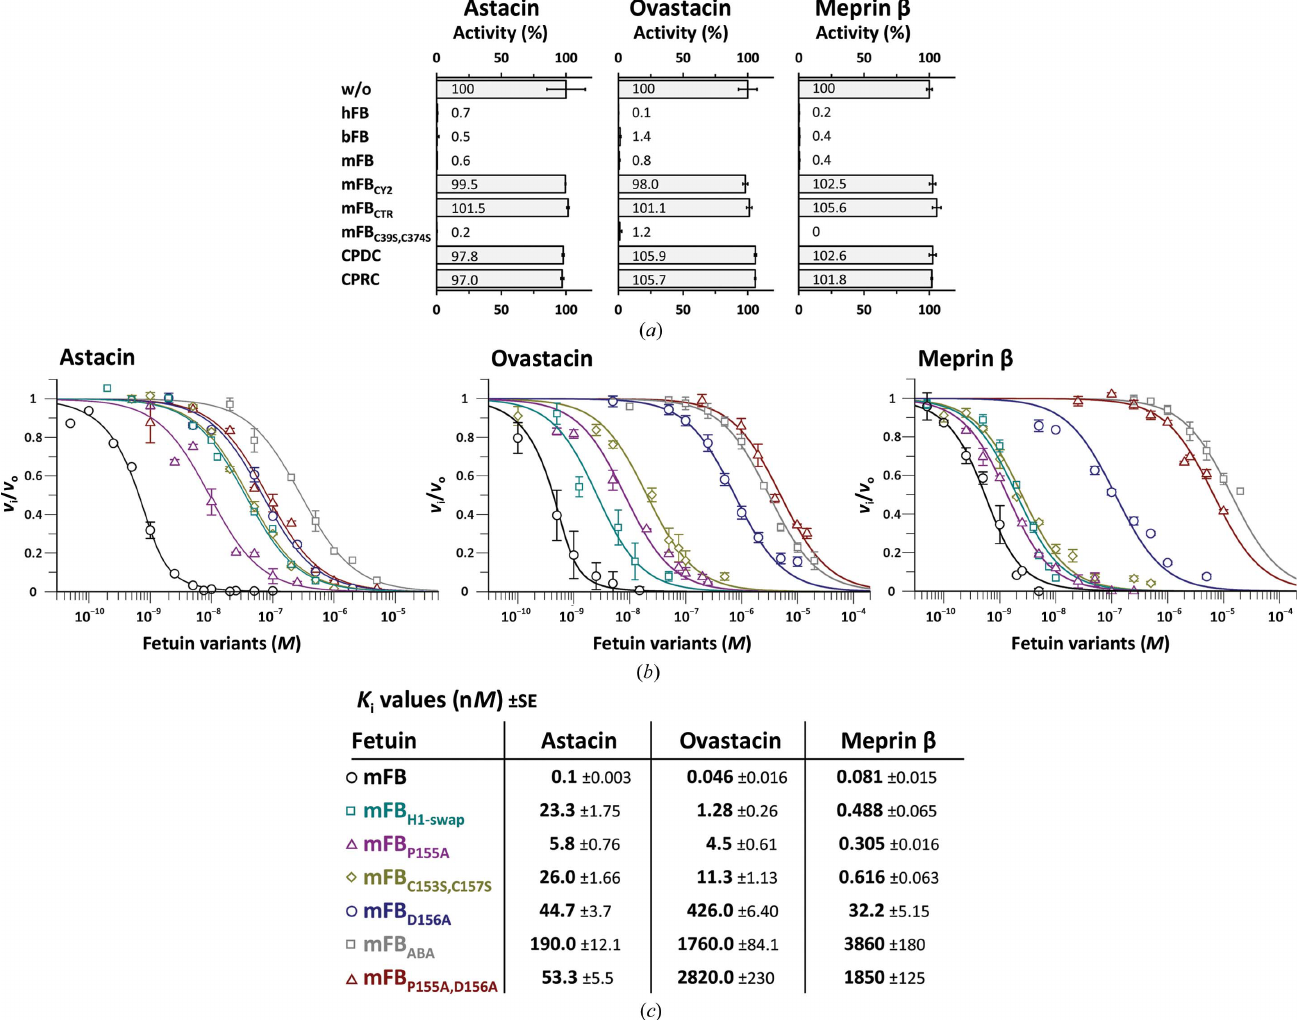
Figure 3 In vitro validation of the inhibitory mechanism. ( a ) Activity (%) of astacin (at 1 n M concentration), meprin (cid:3) (at 1 n M concentration) and ovastacin (at 5.6 n M ) in the presence of fetuin-B variants at 300 n M (CPDC and CPRC) or 12.5 n M (other variants). Full astacin, meprin (cid:3) and ovastacin activities (100%) correspond to substrate-turnover rates of 35.4 (cid:8) 5.7, 7.7 (cid:8) 0.2 and 10.7 (cid:8) 0.8 n M s (cid:4) 1 , respectively; w/o, without fetuin; hFB, human fetuin-B; bFB, bovine fetuin-B; mFB, murine fetuin-B; mFB CY2 , CY2 domain of mFB; mFB CTR , CTR domain of mFB; mFB C39S,C374S , double point mutant of murine fetuin-B; CPDC and CPRC, cyclic peptides comprising the respective sequences. Experiments were performed in triplicate; error bars indicate standard deviations. ( b ) Plot of fractional velocity (logarithmic scale) with different fetuin-B variants: mFB, murine fetuin-B; mFB ABA , variant with CY1 and CTR from mouse fetuin-A and CY2 from mFB; mFB H1-swap , mutant replacing CY2 hairpin I with CY1 hairpin I; mFB P155A , mFB D156A , mFB P155A,D156A and mFB C154S,C157S are point mutants of murine fetuin-B. Enzyme and substrate concentrations were 1.0 n M and 195 m M for astacin, 0.5 n M and 26 m M for meprin (cid:3) and 0.7 n M and 26 m M for ovastacin, respectively. Error bars indicate standard deviations. ( c ) K i values determined from ( b ) using Morrison’s equation with the respective standard errors